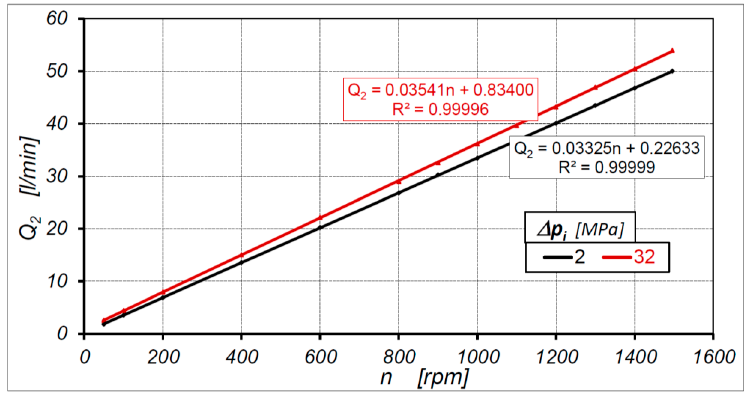
Figure 12. Characteristics of motor output flow rate Q 2 vs. rotational speed n at Δ p i = const. The influence of liquid compressibility is omitted.